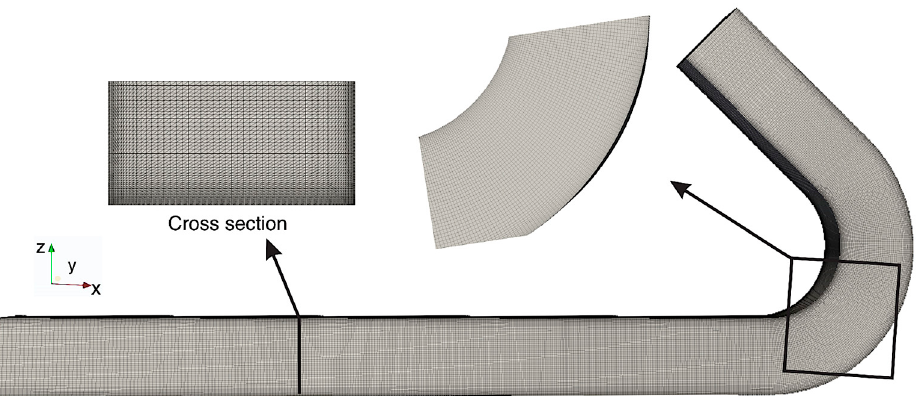
Figure 2. Structured mesh for numerical simulations, also showing a detailed view of the mesh and the cross ‐ sectional view.